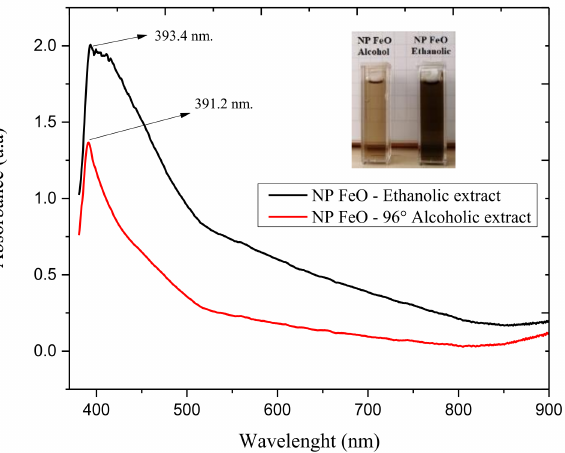
Figure 2. Results by UV-vis spectrophotometry of colloids of FeO NPs synthesized by the green route.